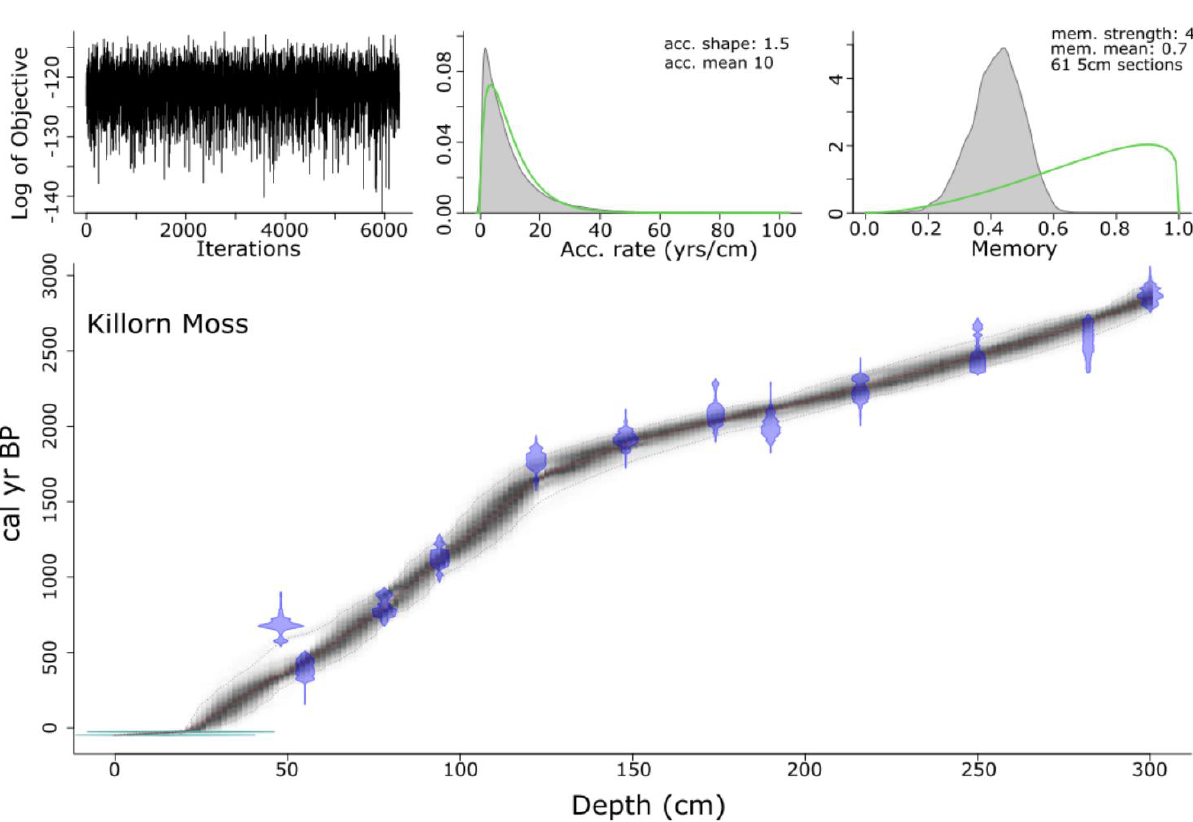
Figure 2. ‘Bacon’ based Bayesian age-depth model for the core from Killorn Moss. The three upper charts denote, from left to right, the stability of the Markov Chain Monte Carlo iterations (>1000 iterations) and the prior (green line) and posterior (grey shading) accumulation rate and memory employed. In the lower chart, blue shading shows age distributions of calibrated AMS 14 C dates, green shading denotes calendar dates incorporated into the model from Spheroidal Carbonaceous Particles (SCPs) data, and grey shading denotes the posterior age-depth model bounded by grey dots showing the 95 % probability intervals of the model. minimise any potential contamination.